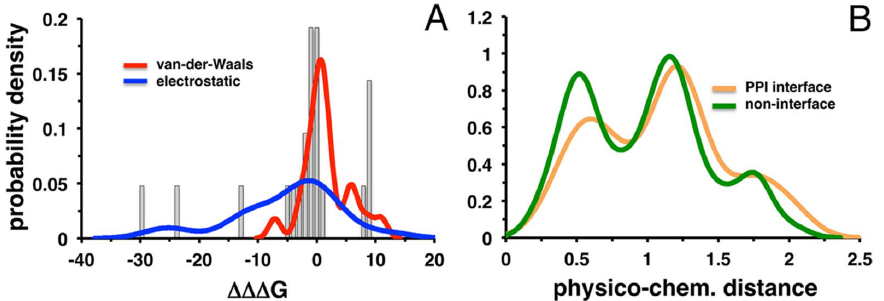
Figure 2. The effect of mutations on protein binding. ( A ) Distribution of binding energy difference upon mutation for electrostatic and van- der-Waals components. The electrostatic component of binding energy was significantly shifted toward negative values compared to the van-der- Waals component (p-value=1.3 6 10 2 3 ) ( B ) Distributions of physico-chemical distances between amino acids that correspond to glioblastoma mutations on protein-protein interfaces and non-interface regions. Distributions that referred to amino acid substitutions on protein-protein interfaces had significantly larger distances compared to non-interface regions (p-value=0.011).